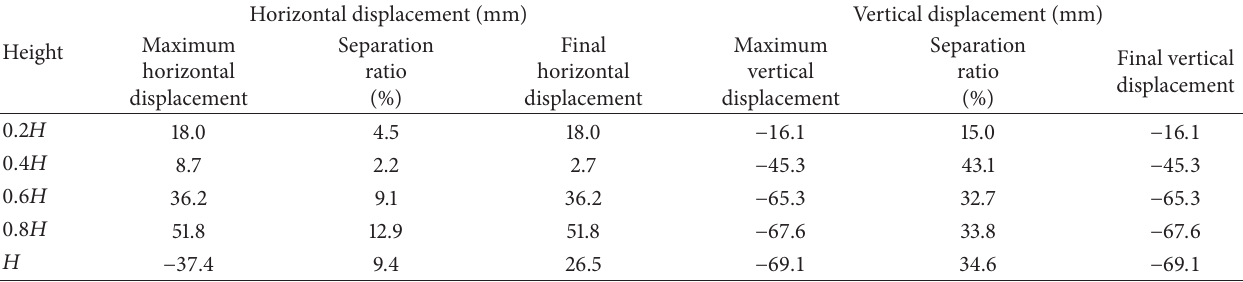
Table 7: Separation ratio for 400 mm reinforcement spacing.